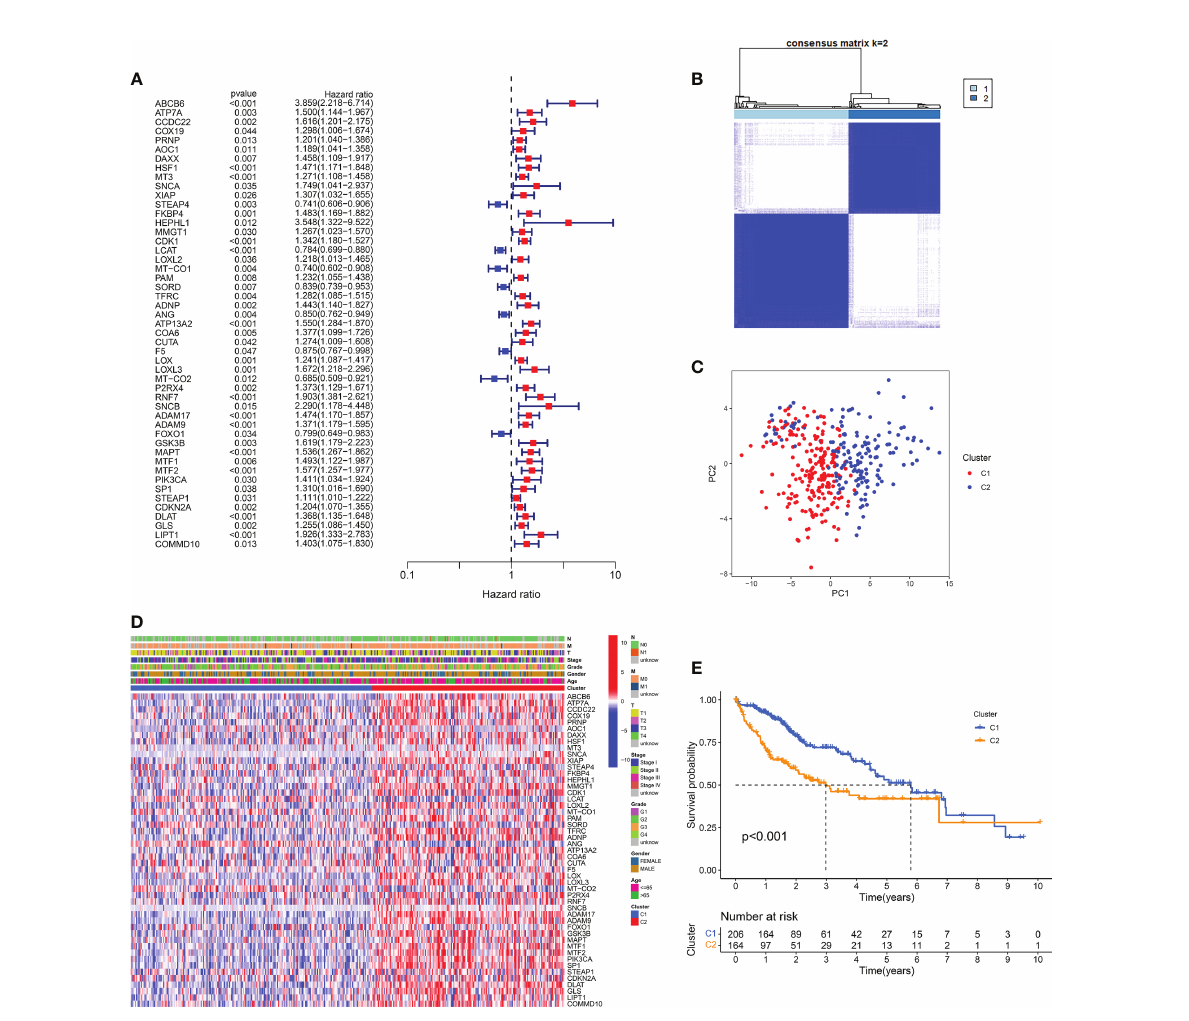
FIGURE 2 CMCRG subtypes and clinicopathological of two distinct subtypes of samples divided by consistent clustering. (A) Forest plot of copper metabolism and cuproptosis-related genes. (B, C) Cluster analysis and principal component analysis of two subtypes. (D) The expression pro fi le of copper metabolism and cuproptosis-related genes in the two subtypes. (E) Survival curve. T: size of the tumor; N: regional lymph node involvement; M: metastasis; Stage: tumor progression stage; Grade: grade of tumor pathological